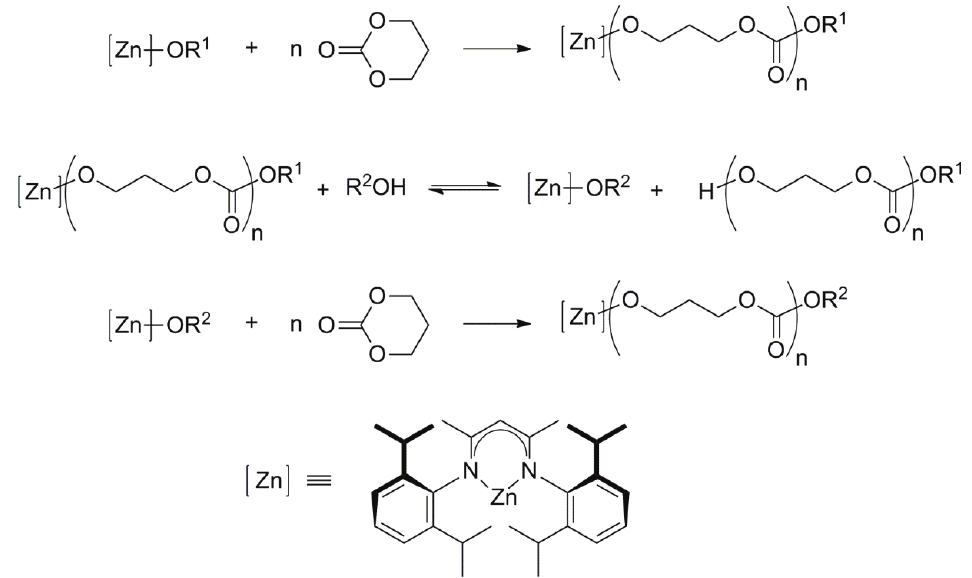
Figure 59. [Zn] mediated living ring-opening polymerization of trimethylene